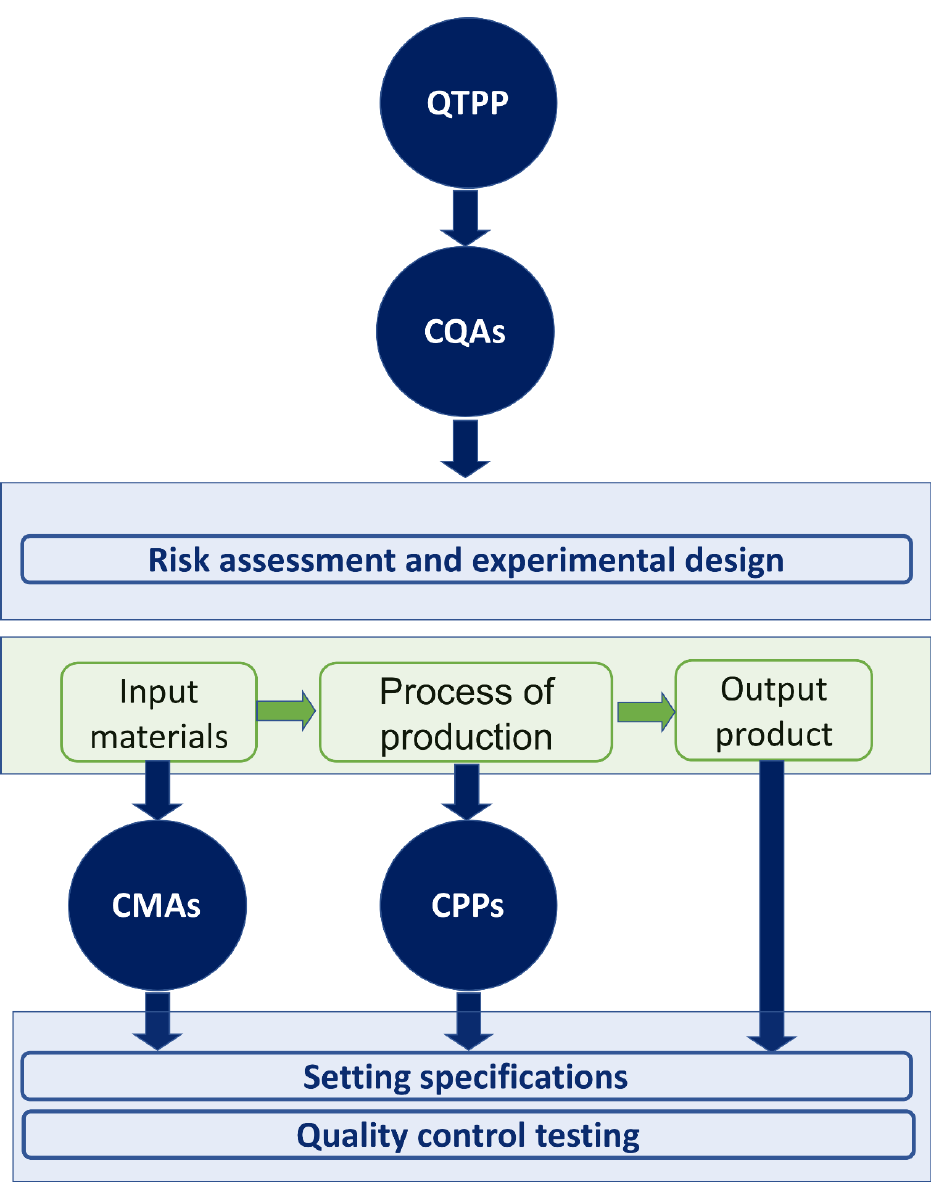
Figure 2. QbD roadmap, and QTPP and CQAs key elements.